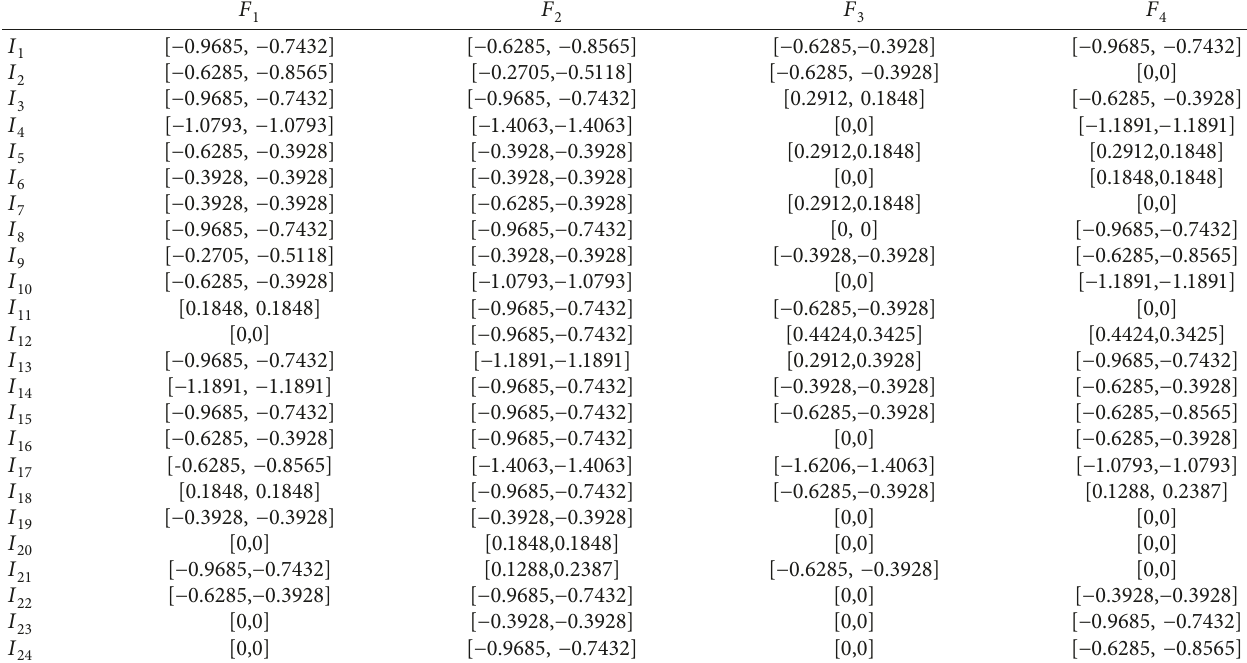
Table 5: Prospect values of decision-making indices of each scheme.